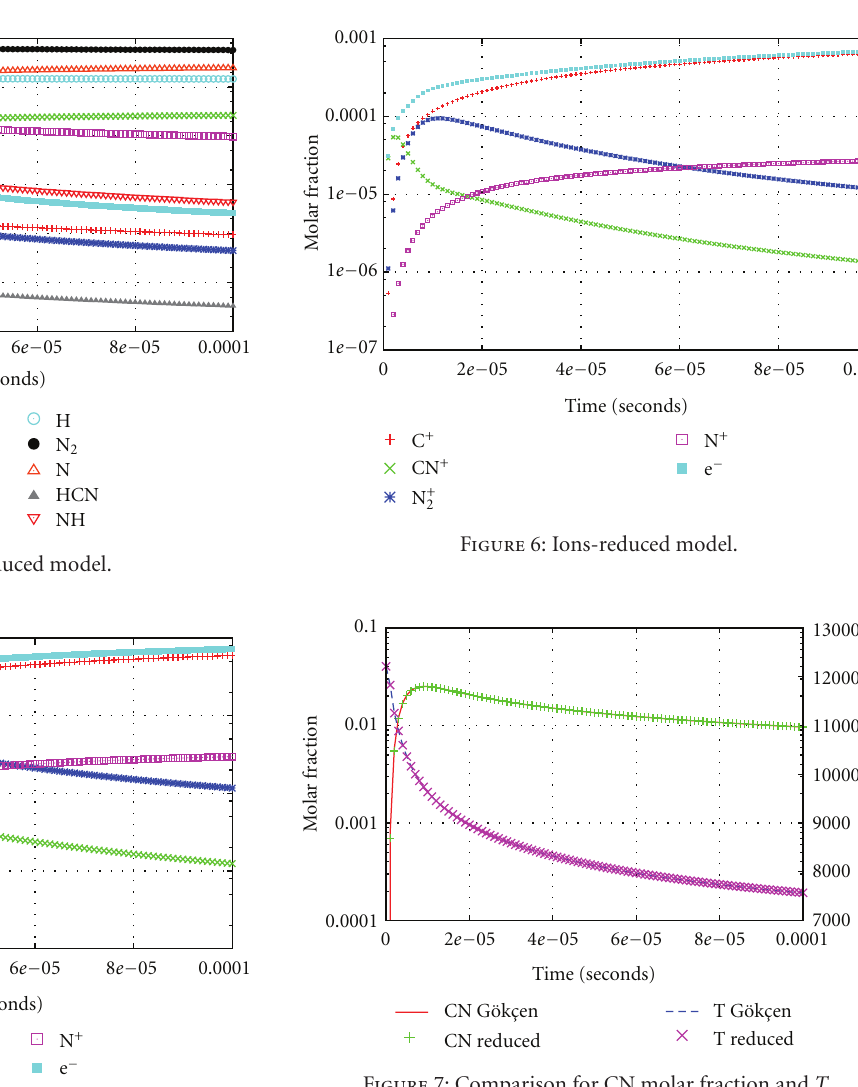
Figure 7: Comparison for CN molar fraction and T